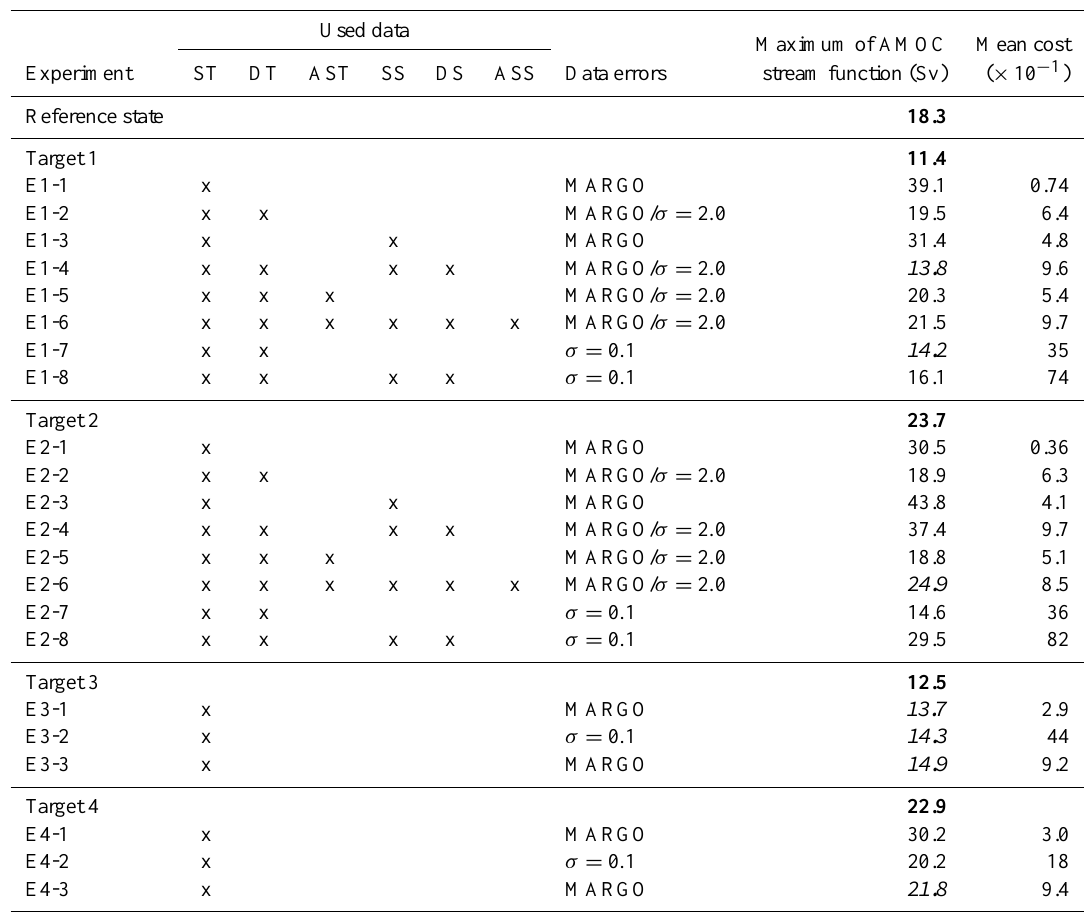
Table 1. Summary of experiment settings and results. Used data are specified as follows. ST: surface temperature from MARGO data locations, DT: Deep temperature from MARGO data locations, AST: surface temperature from all other grid cells, SS: surface salinity from MARGO data locations, DS: deep salinity from MARGO data locations, and ASS: surface salinity from all other grid cells. Maximum values of the AMOC stream function are shown in Sv (1Sv = 10 6 m 3 s − 1 ). Reconstructed AMOC strength that is closer to the target than half of the difference between the starting point (reference state) and target is shown in italics. The rightmost column shows the mean cost (i.e., the value of objective function divided by the number of model-data comparisons). The unit of data error σ is K for temperature and psu for